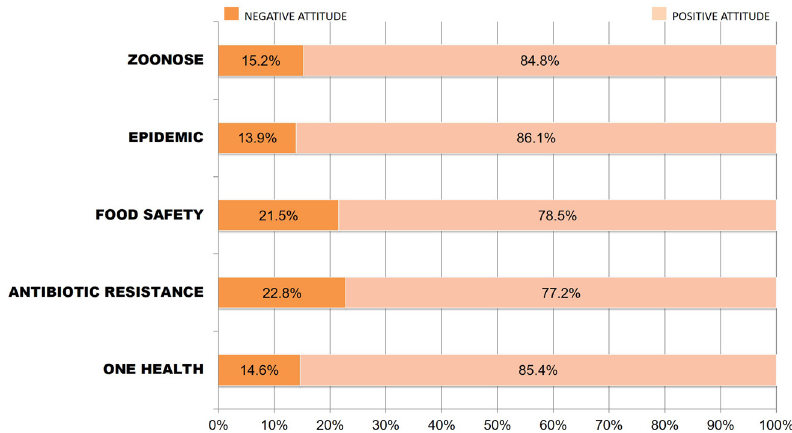
Figure 1: Distribution of the students